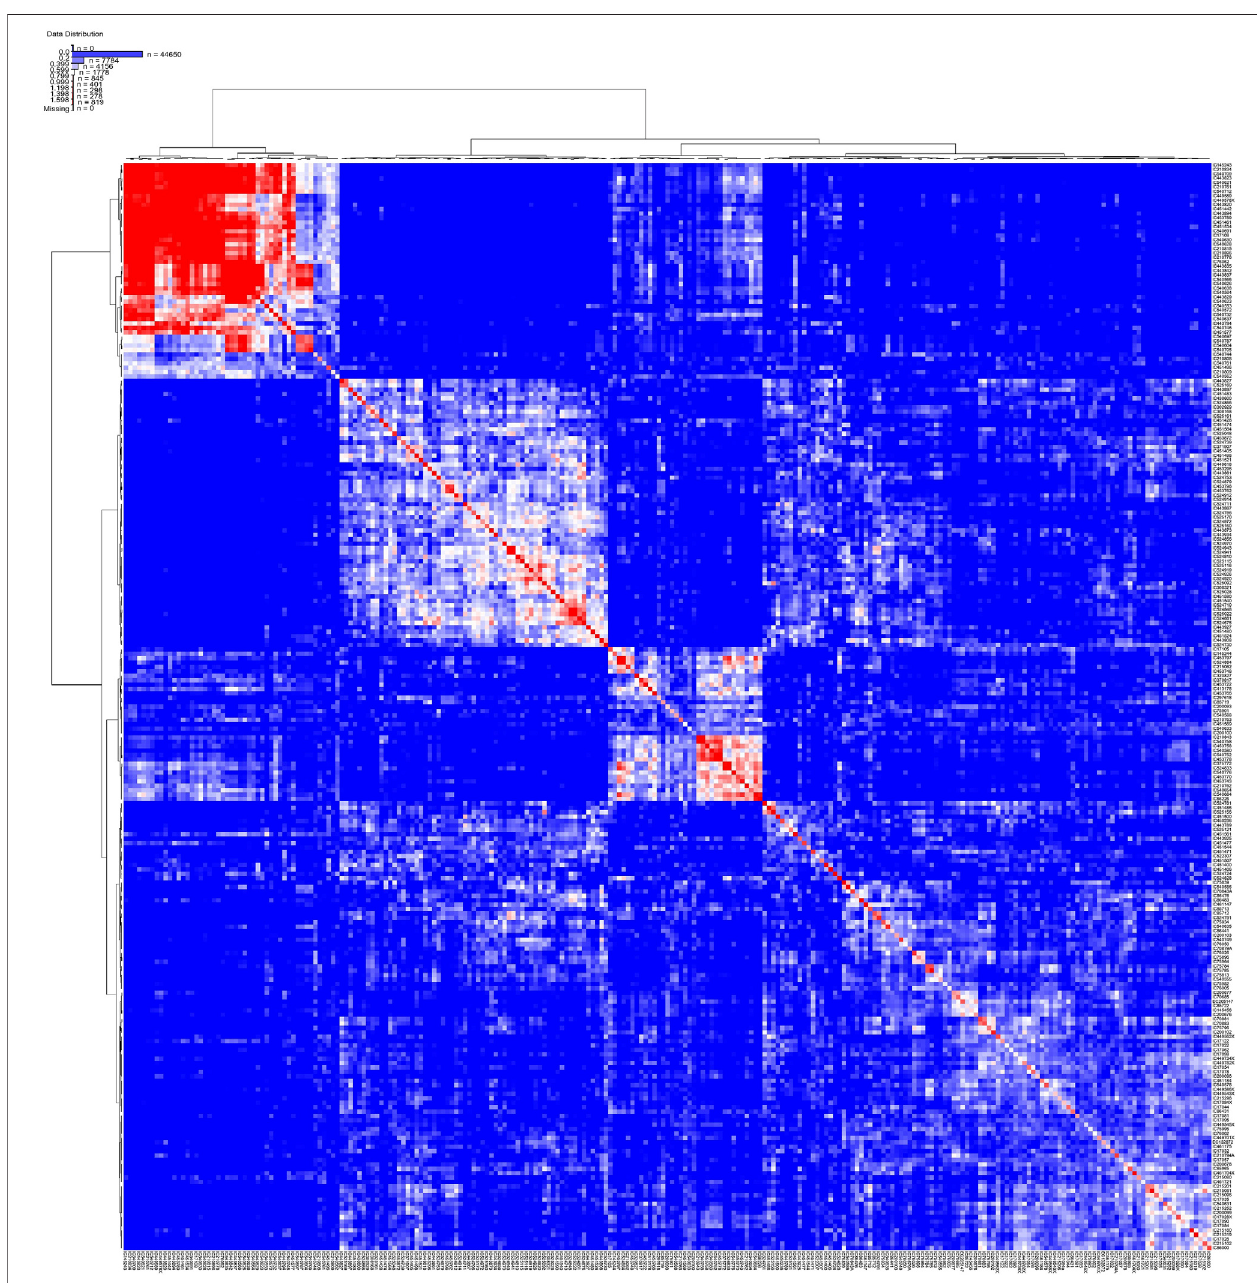
FIGURE 9 | Structured heat map showing the relatedness of rice accessions from core